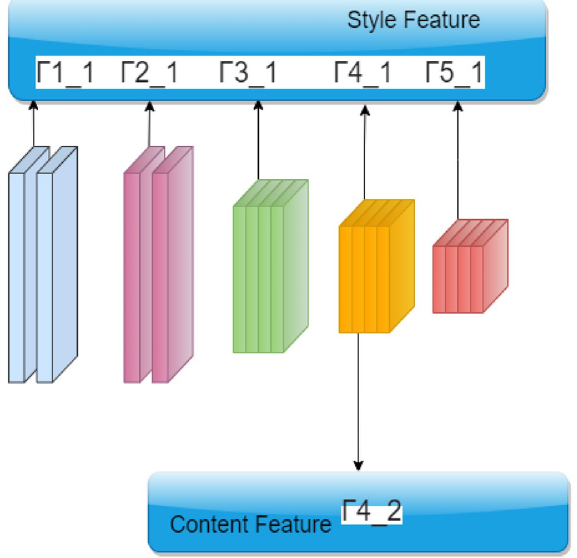
Figure 9. Architecture of VGG-19 network used in style transfer where the layers Ŵ 1 ( 1 ) , Ŵ 2 ( 1 ) .. capture style features and the layer Ŵ 4 ( 2 ) captures the content